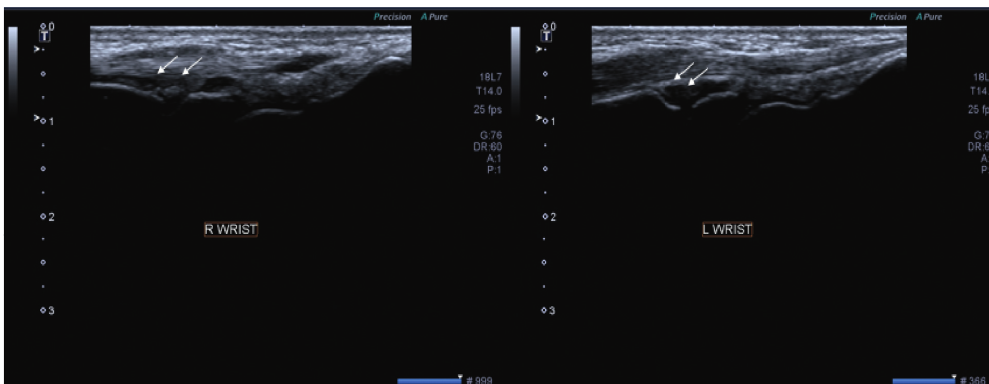
Figure 8: Grayscale images of both wrist joints demonstrating moderate synovial thickening (white arrows). The findings are consistent with Grade 2 synovitis. Extensor tendons of both wrist joints also show thickening and hypoechogenicity representing tendonitis.